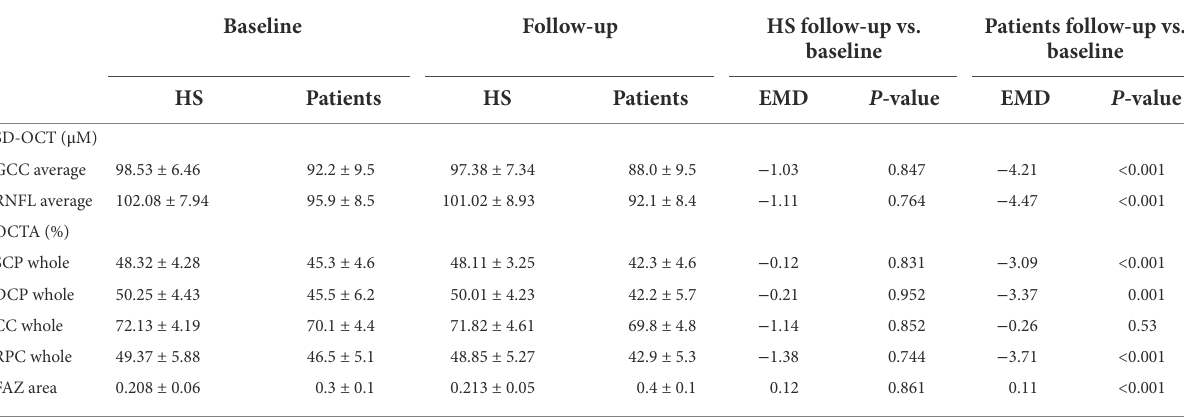
TABLE 2 Comparison in SD-OCT and OCTA parameters among HS and all patients at baseline vs. follow-up. Baseline Follow-up HS follow-up vs.